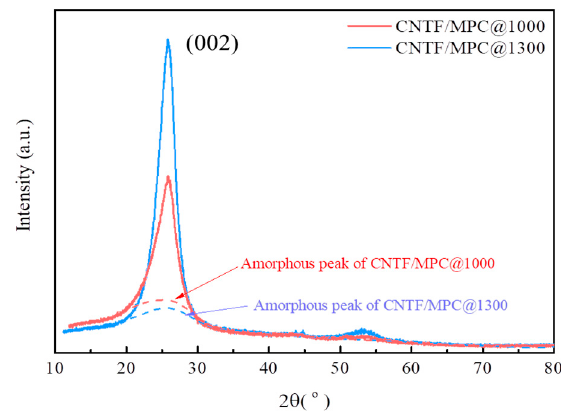
Figure 8. XRD patterns of CNTF/MPC@1000 and CNTF/MPC@1000